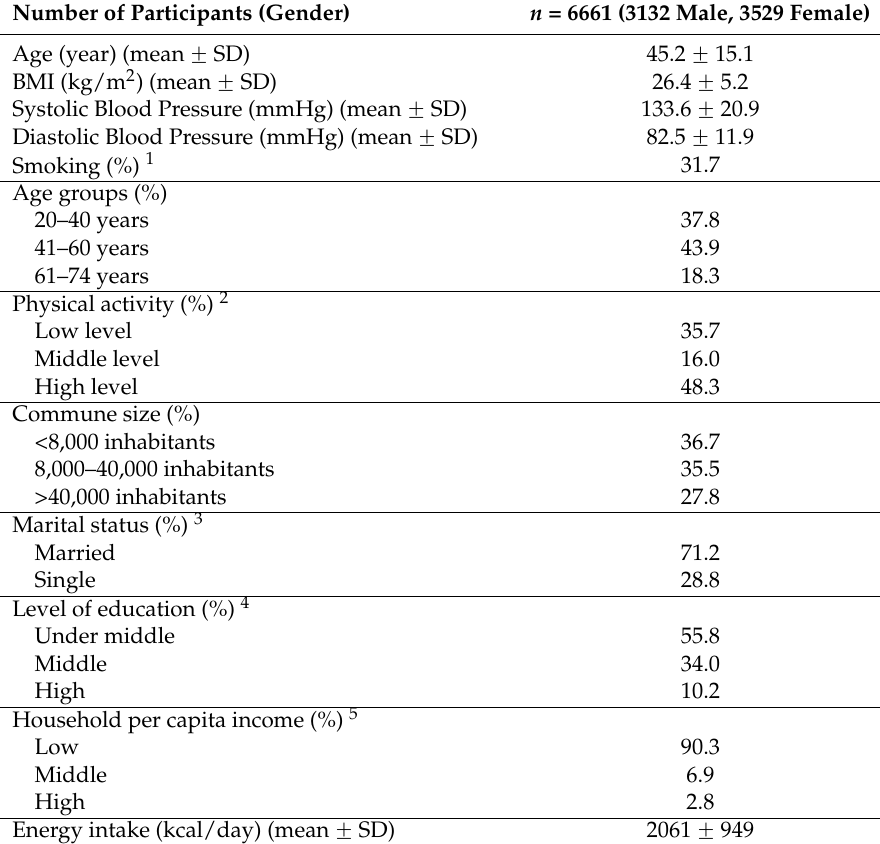
Table 1. General description of the studied